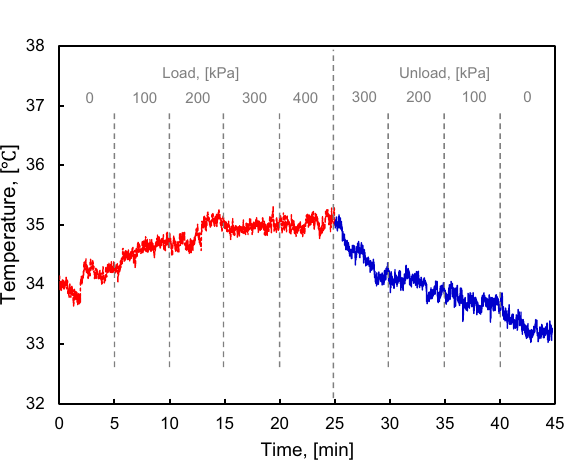
Figure 6. Thermal image measured by infrared thermography in the passive method.